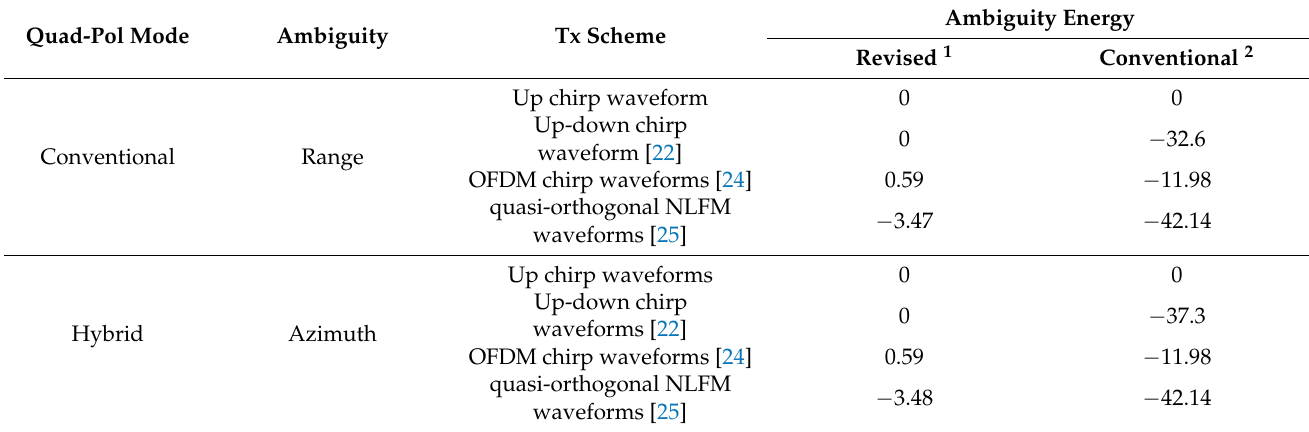
Table 2. Measured ambiguity energy of a point target.